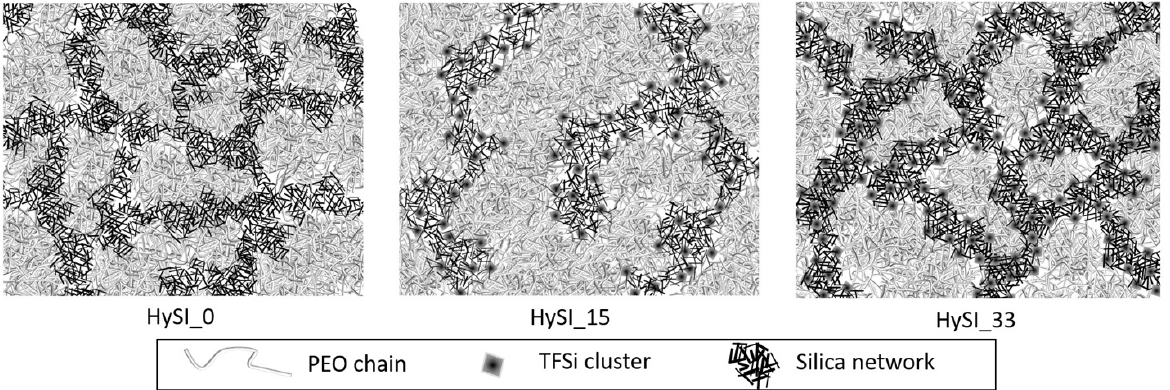
◦ C for HySI_0, HySI_15 and